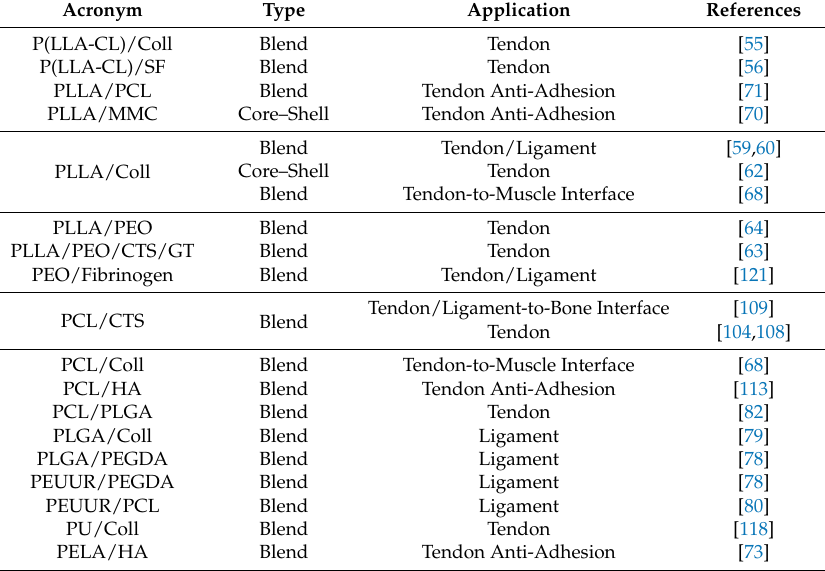
Table 2. Electrospun blends and core–shell fibers and their applications in tendon and ligament tissue engineering.